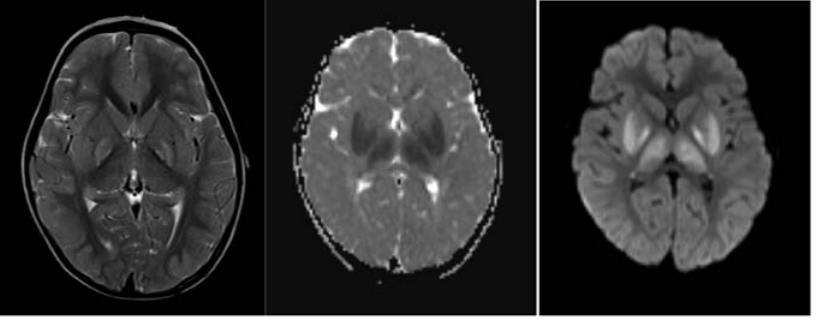
Figure 1. T2-weighted and diffusion weighted images. Increased intensity on both globus pallidus is present on T2-weighted image. Restricted diffusion is prominent on both thal- ami, putamina and globus pallidus.